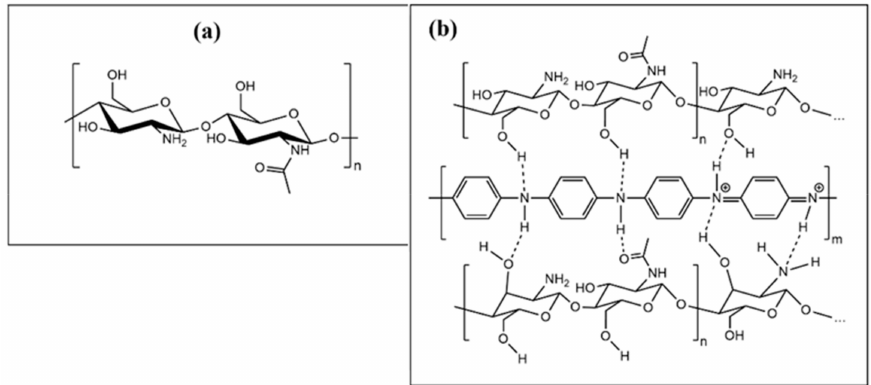
Figure 1. Schematic illustration of molecular structures of polymer fragments: ( a ) pristine chitosan with deacetylated (left) and acetylated (right) monomer units; and ( b ) CHT–PANI composite, where n and m refer to arbitrary respective chain lengths of chitosan and PANI. Panel ( b ) is based on the results reported in Reference